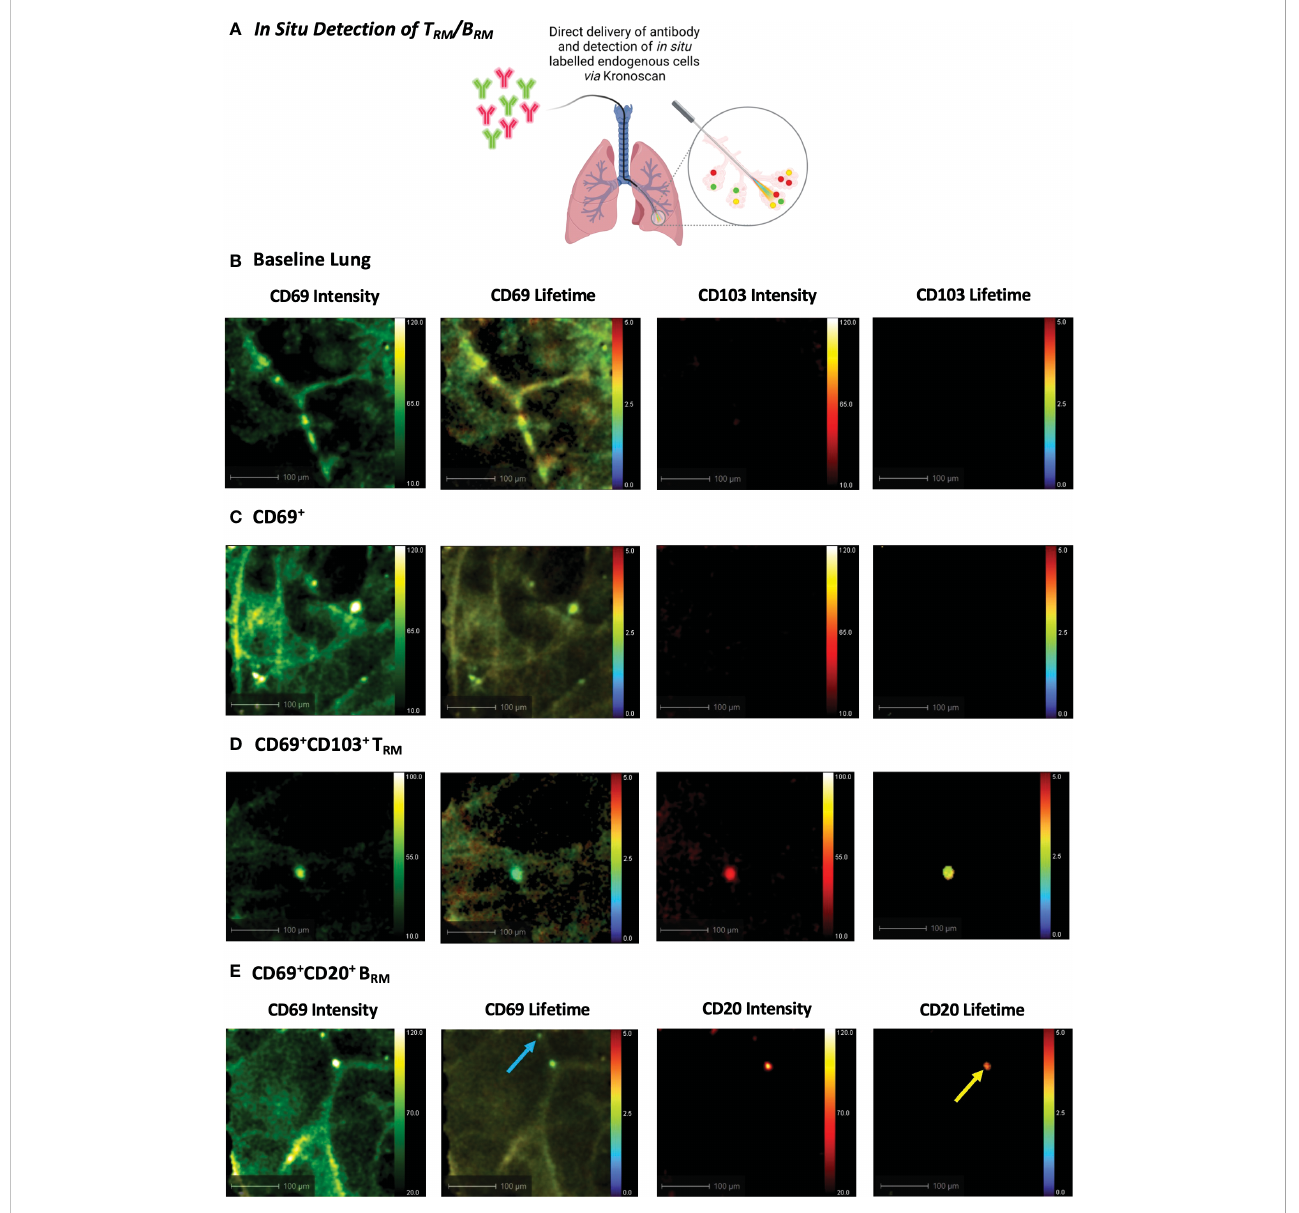
FIGURE 6 In Situ Detection of T RM /B RM in Human Lung following Antibody Delivery. (A) T RM or B RM antibodies were instilled into the alveolar space via Panoptes fi bre and imaged with KronoScan. (B) Baseline lung imaging prior to antibody delivery. (C) In situ detection of CD69 + cells. CD69 and CD103 antibodies were instilled into the alveolar space to detect T RM . (D) In situ detection of CD69 + CD103 + T RM . (E) In situ detection of B RM . CD20 and CD69 antibodies were instilled into the alveolar space to detect B RM . Blue arrow indicates CD69 + cells and yellow arrow points CD69 + CD20 + B RM . Representative images from n=3